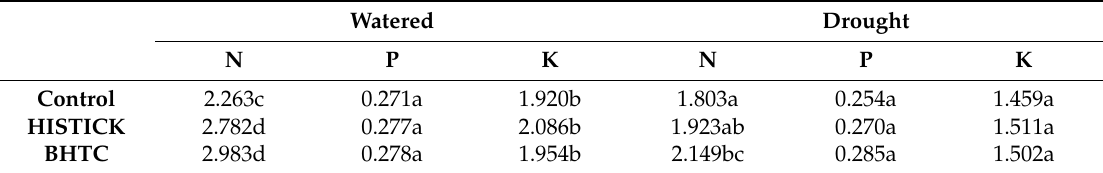
Table 2. Interaction effects of treatments (Control, HISTICK, BHTC), and irrigation (Watered, Table 1. Nutrient concentrations in soybean inoculated with B. japonicum (HISTICK) and B. japonicum Drought) on the plant N, P, K content, shoot and root biomass, and nodule number. Significance (BHTC, HTC-based Rhizobia) under watered and drought conditions. The plants were grown in a denoted by *** p < 0.001. greenhouse for 35 days.